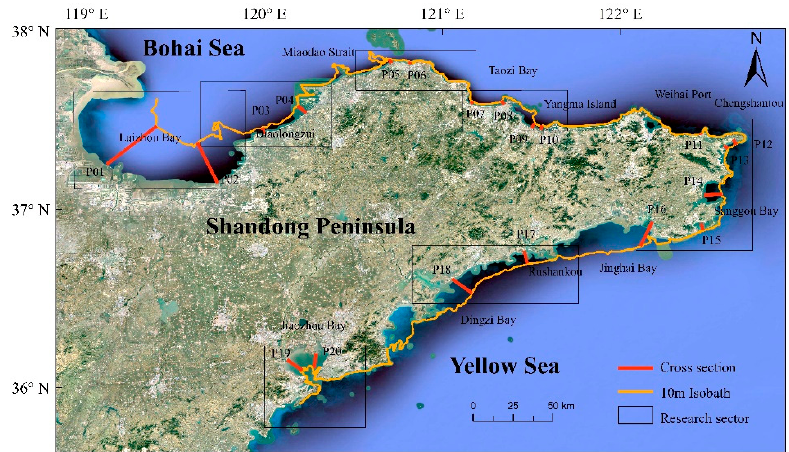
Figure 1. Geographical location of the study area and distribution of cross-sections.